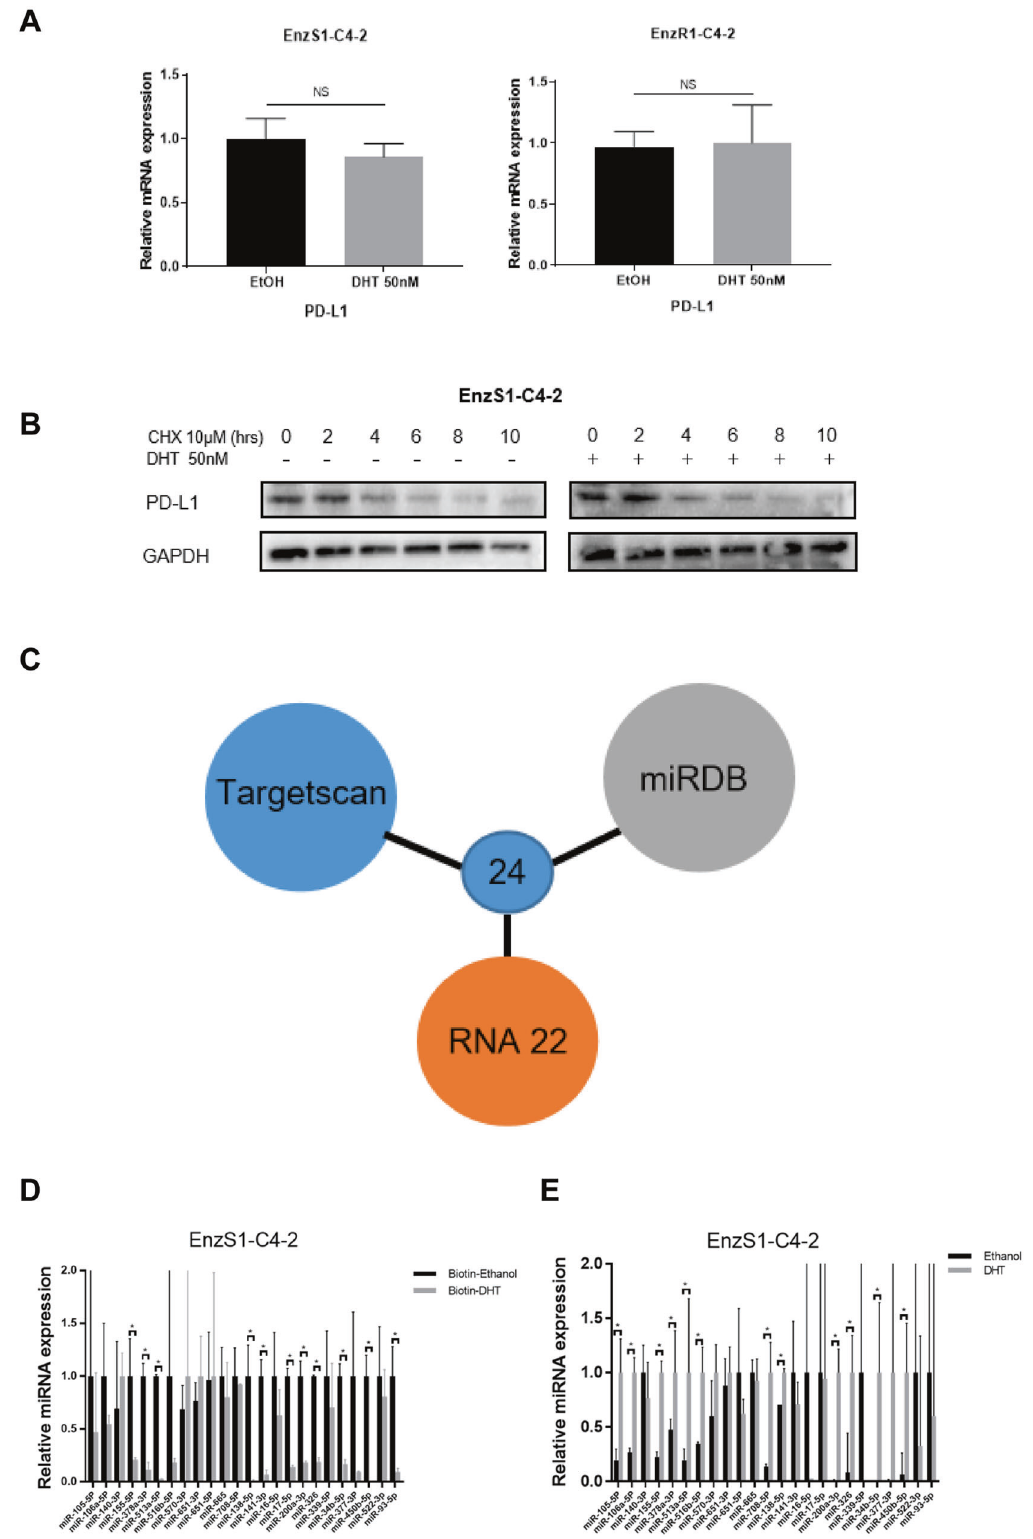
Fig. 3 A high dose DHT/AR can increase the PD-L1 expression via suppressing miRNAs function. A qRT-PCR was performed to test the PD-L1 mRNA expression in EnzS1-C4-2 (left panel) and EnzR1-C4-2 (right panel) after high dose DHT treatment for 48 h. B PD-L1 protein stability after 50 nM DHT treatment at 0, 2, 4, 6, 8, and 10h. C Venn diagram for prediction of candidate miRNAs targeting PD-L1 using 3 miRNA related websites (Targetscan, miRDB and RNA 22). D miR-155-5p, miR-378a-3p, miR-513a-5p, miR-138-5p, miR326, miR-141-3p, miR-17-5p, miR-200a-3p, miR-34b-5p, miR-450b-5p, and miR-93-5p, not the other 13 miRNAs, were decreased in the pull-down assay, demonstrating the direct binding of PD-L1. E qRT- PCR was performed to show quanti fi cation of PD-L1 related miRNAs expression after 50 nM DHT treatment. * p < 0.05, NS Not Signi fi cant.